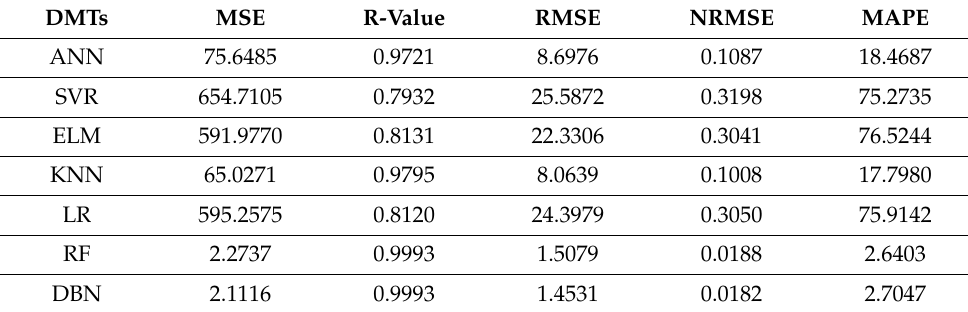
Table 11. Performance of data-mining techniques in fault location. DMTs MSE